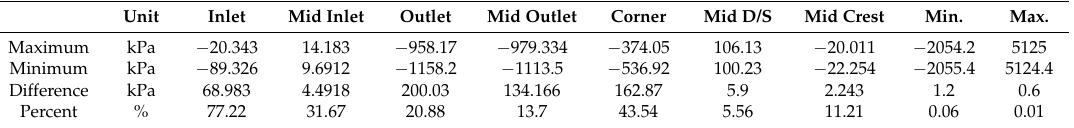
Table 8. Statistical analysis of the principle stress results at the maximum upstream water level.